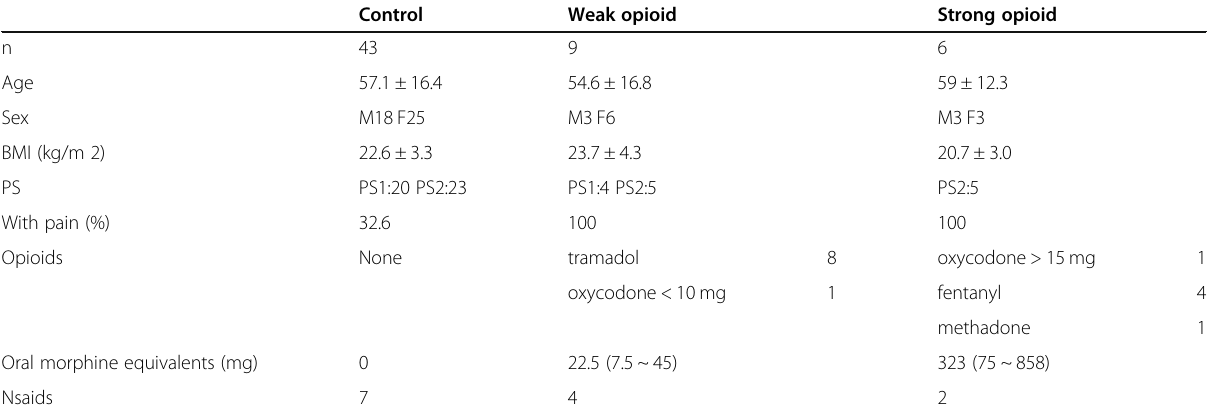
Table 1 Patient demographic